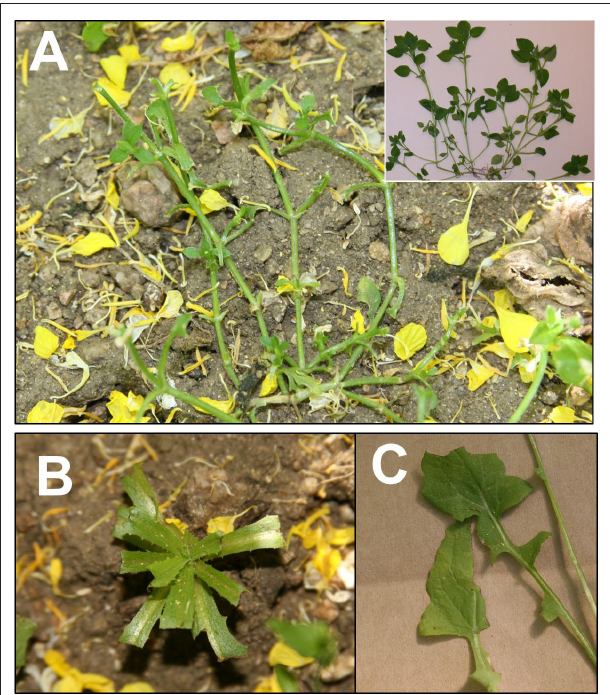
FIGURE 7 | Evidence of weed folivory by sparrows in the understory of a mustard ( S. alba and Brassica juncea) cover crop. (A) Common Chickweed ( Stellaria media) with most leaves removed; the insert in the top right shows a plant that has not been defoliated. (B) Defoliated rosette of Annual Sowthistle ( S. oleraceus ). (C) Leaves of S. oleraceus with large areas with removed edges indicating bird feeding.